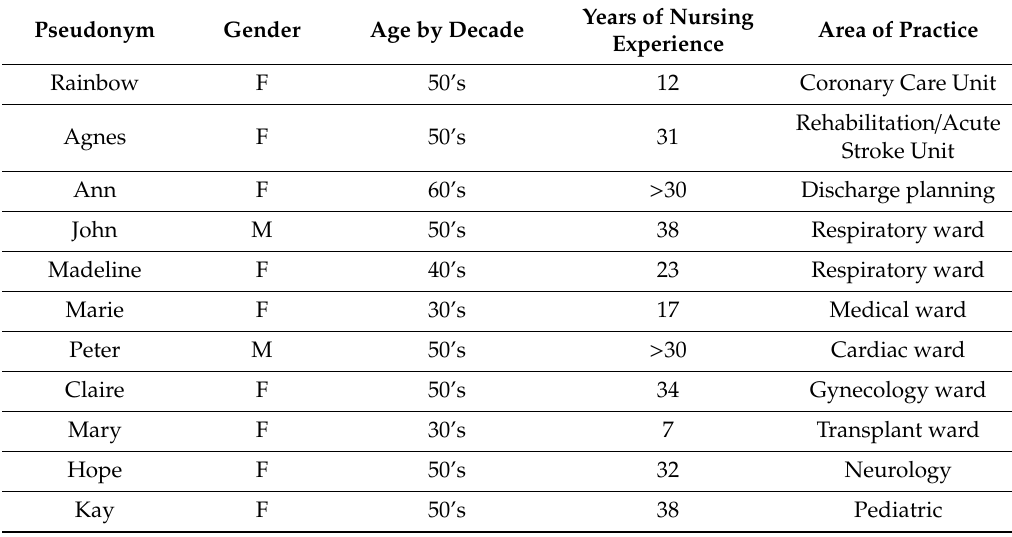
Table 1. Demographic characteristics of the